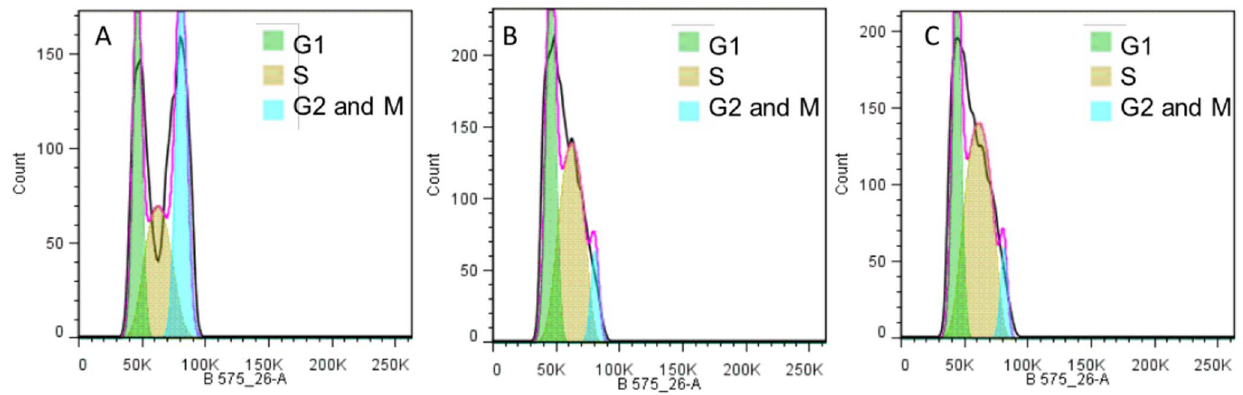
Figure 5. FCM analysis and cell cycle distribution of S.cerevisiae S288C. Analysis of S. cerevisiae S288C cell cycle during exponential phase in synthetic wine (Panel A), before (Panel B) and after exiting (Panel C) the VBNC state analyzed by FCM. The profiles Showed dual-variable plots of cell number versus PI uptake. G1 (green), S (brown), and G2/M (blue) cell populations were quantified. The experiment was repeated at least three times and representative data from single experiment is presented.